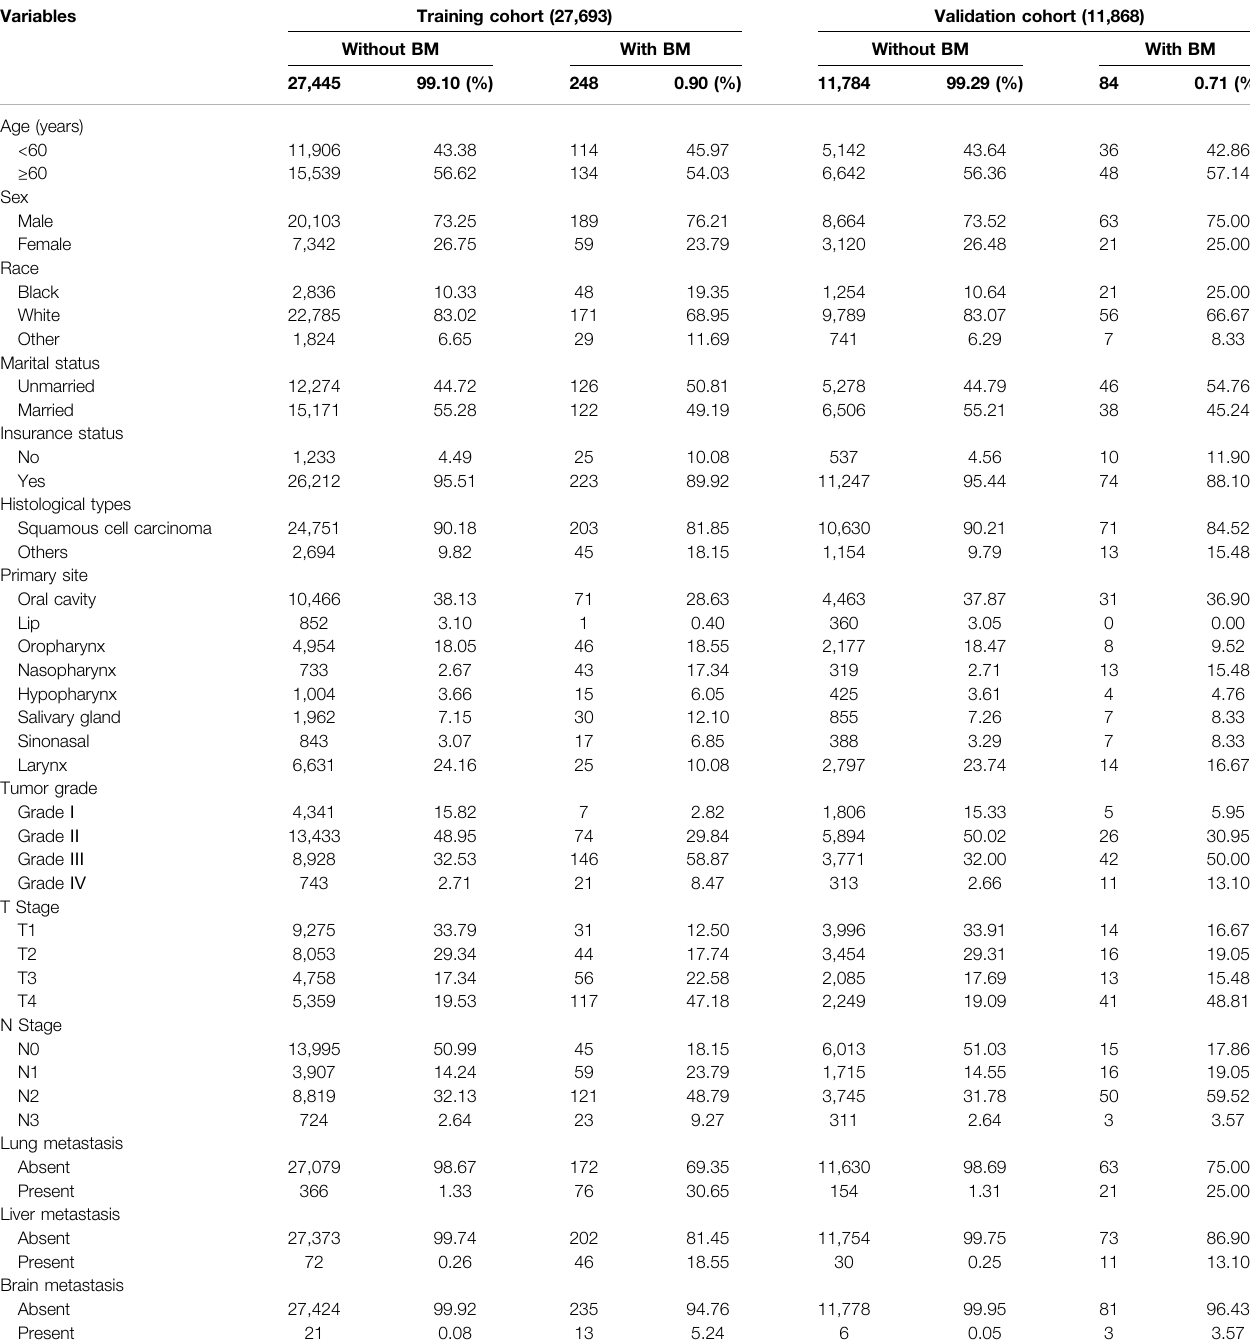
TABLE 1 | The clinical and pathological characteristics of the 39,561 individuals with head and neck cancer who were enrolled in our retrospective cohort analysis.